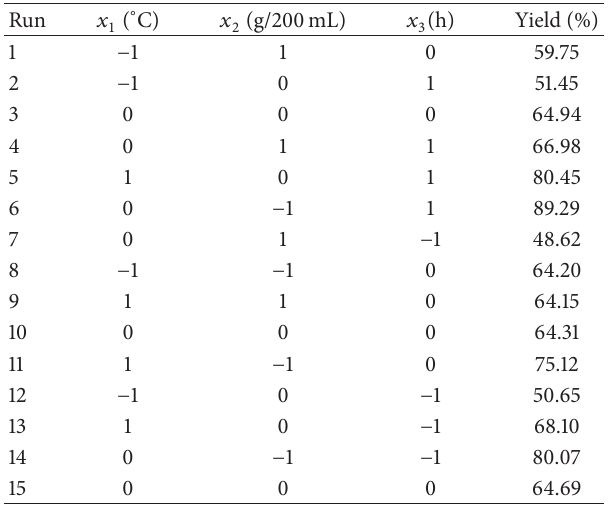
Table 2: The coded variables and experimental yield values in the study.